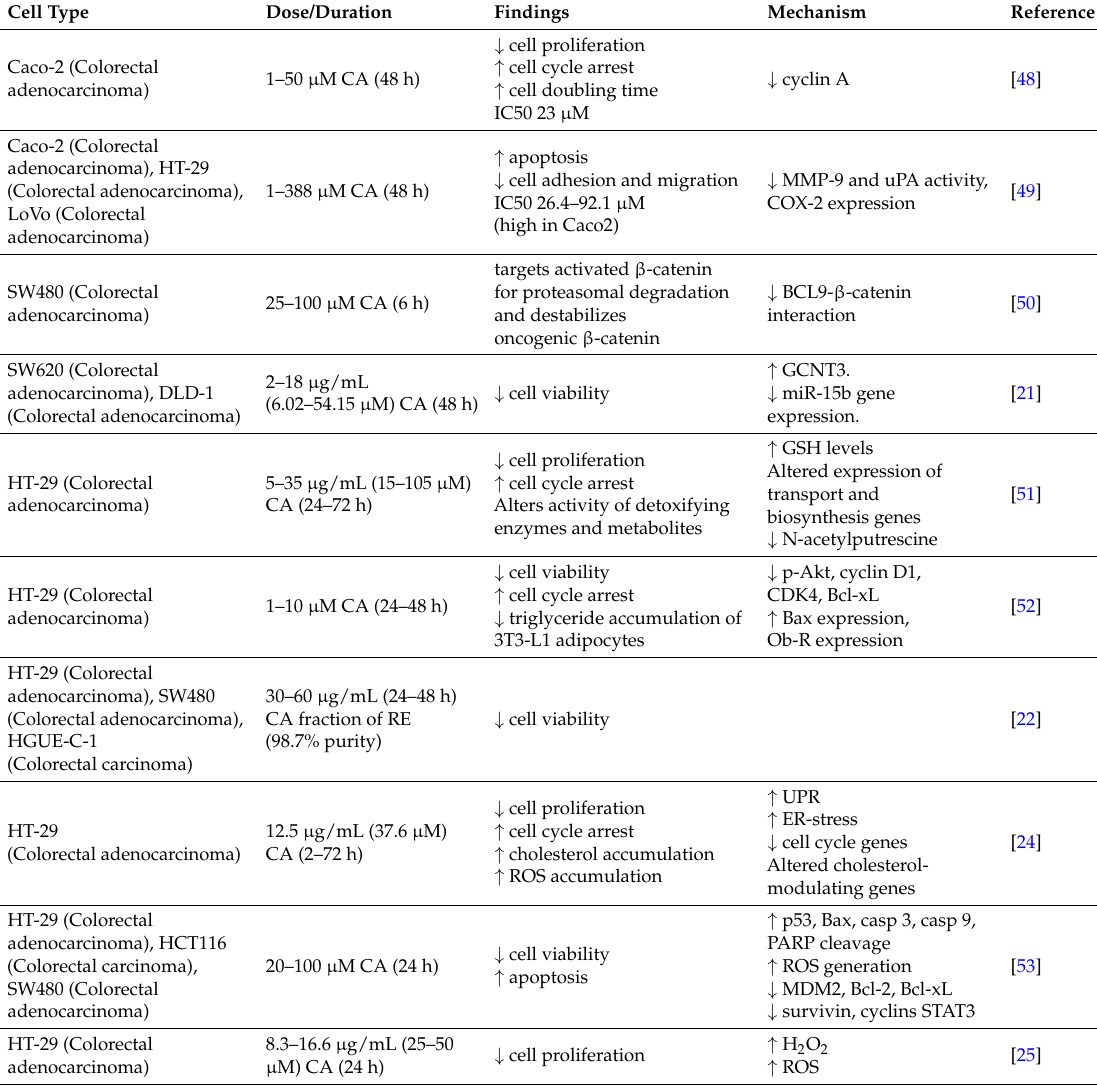
Table 7. Anticancer effects of Carnosic Acid (CA). In vitro studies: colon